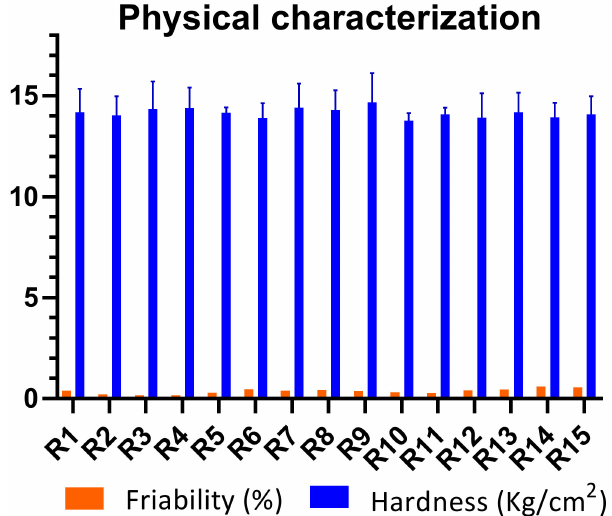
Figure 3. Hardness and friability of buccal